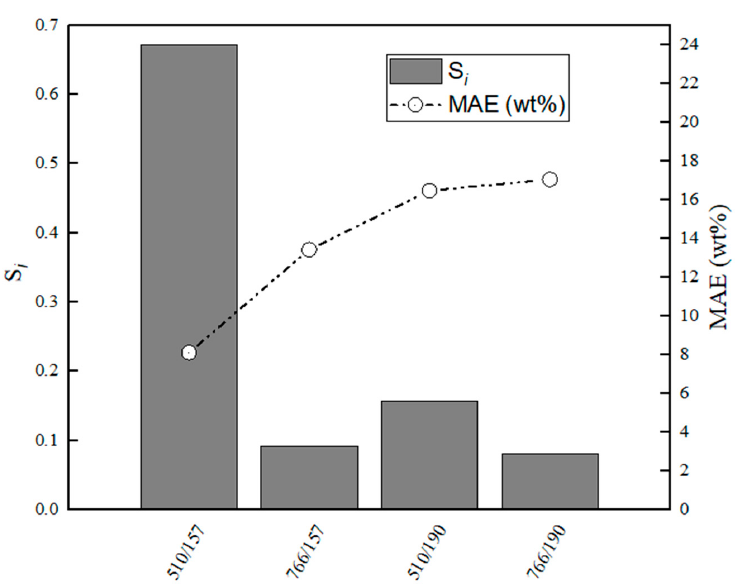
Figure 15. Evaluation of relative stabilities (Si) of the calibration variable candidates and mean absolute error values obtained for training and validation sets for C3A–CaS.